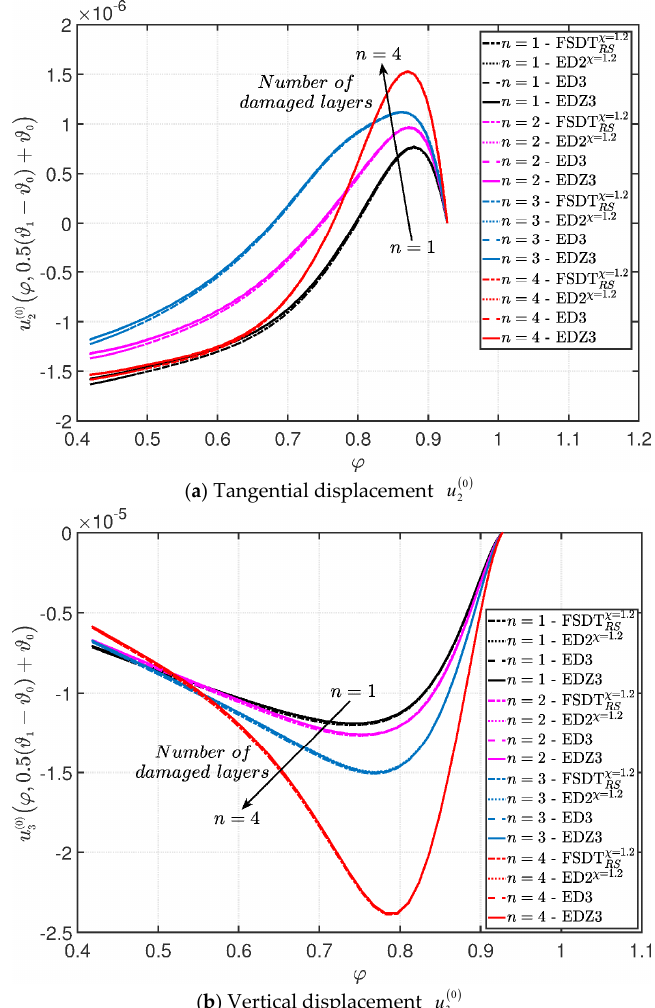
Figure 24. Evaluation of the central vertical displacement profile [m] for the CCCF laminated panel of revolution varying the mechanical parameters of the damage (Gau-6): ( a ) Tangential displacement u 0 ( 0 ) ( b ) Vertical displacement u . The results are obtained by means of several HSDTs. 3